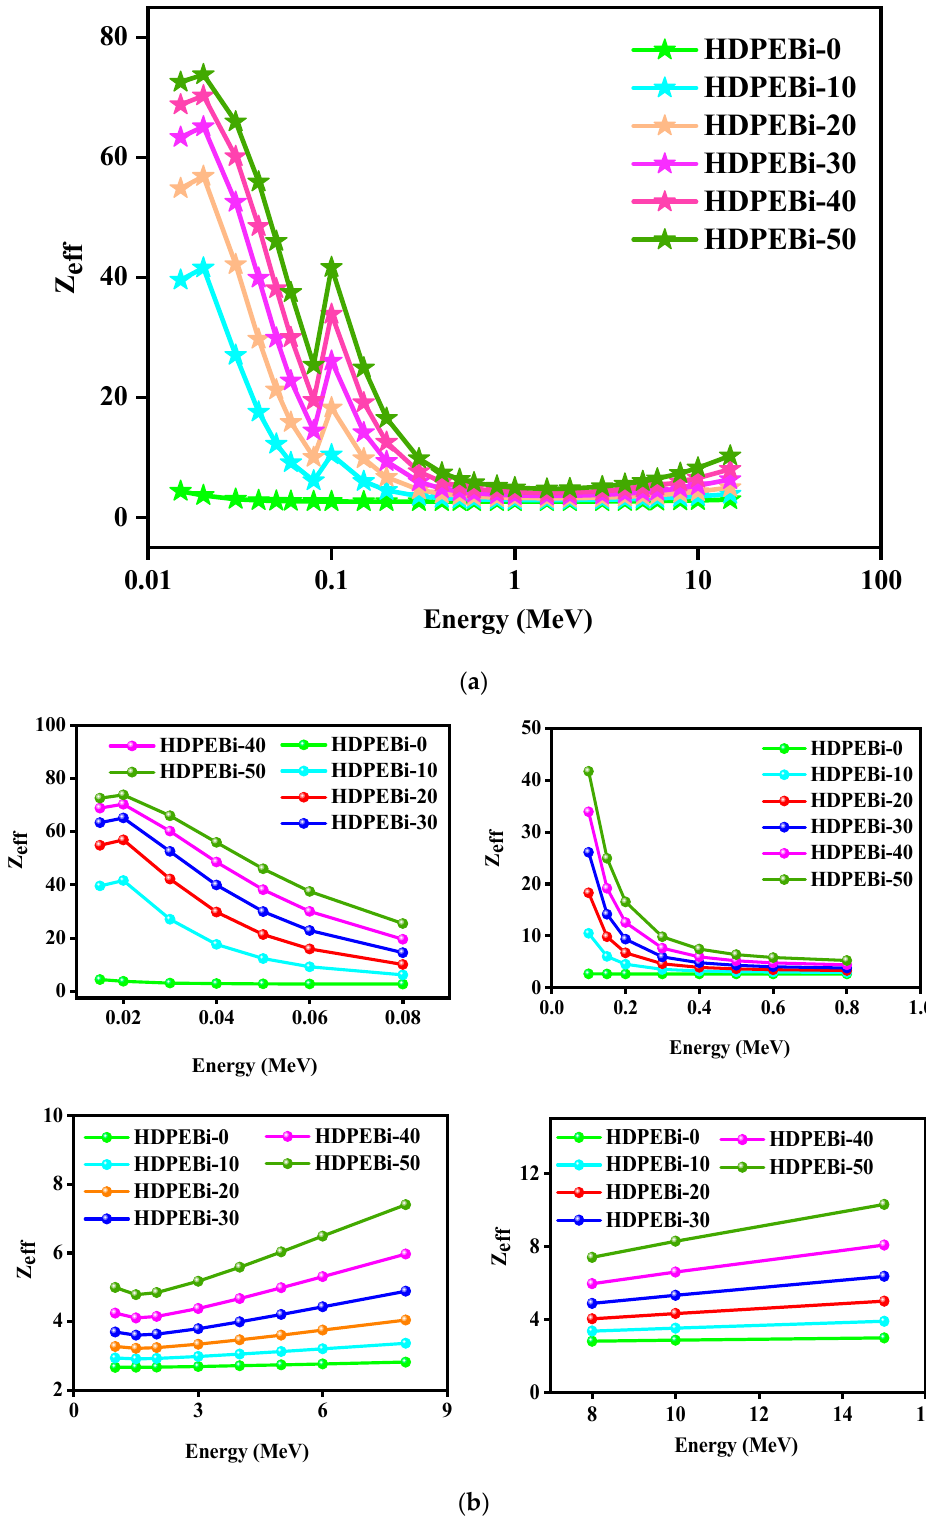
Figure 5. ( a ) Brief presentation of effective atomic numbers as functions of photon energy. ( b ) Detailed presentation of Z eff as functions of photon energy.